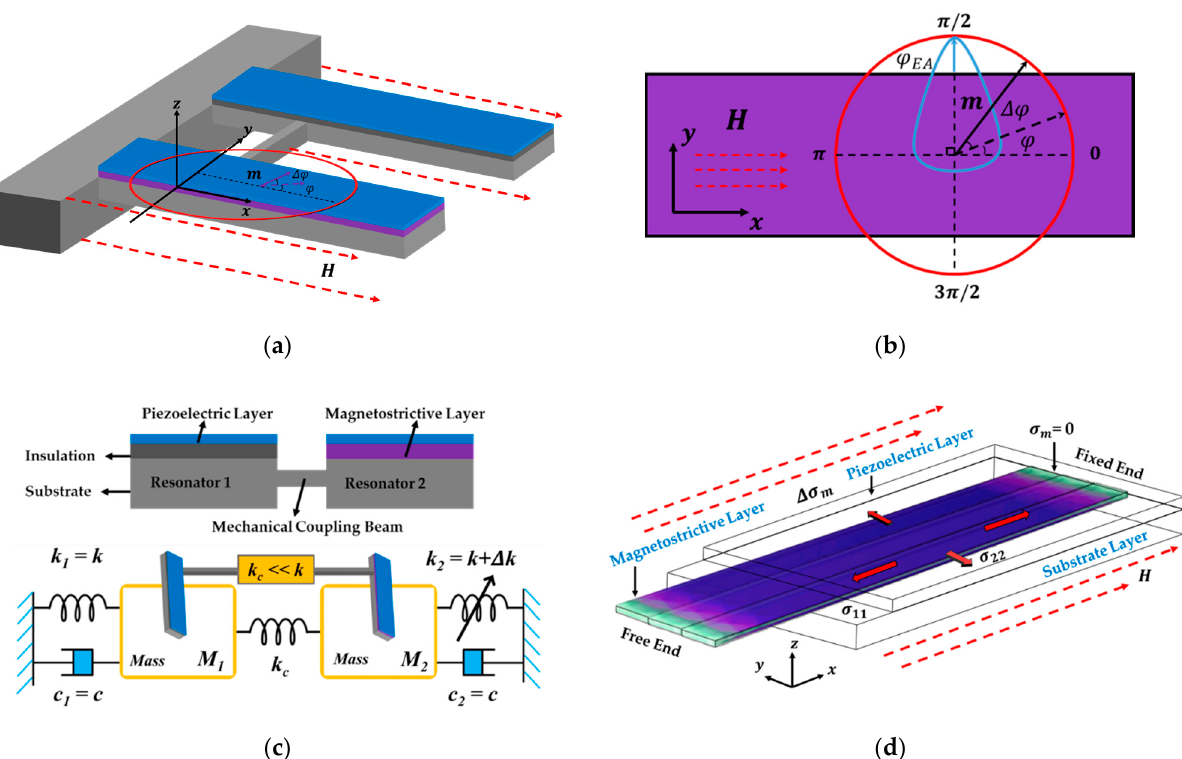
Figure 1. In-plane hard-axis magnetization process of magnetostrictive materials based on the ∆ E- effect and the structure of the weakly coupled resonator in our model. ( a ) The 3D structural diagram of the WCR with the change of magnetization and coordinate system used for the sensor analytical model; ( b ) the enlarged top view of the magnetostrictive layer in ( a ). The red circle represents the normalized in-plane magnetization process of the magnetic layer, and the blue area indicates the angular standard deviation of the easy axis; ( c ) top: the cross-sectional view of the WCR, Resonator 2 is sensitive to the magnetic field with a magnetostrictive film, while Resonator 1 is replaced with an insulating layer in the same position. The two resonators are coupled by a mechanical beam; bottom: the equivalent mass-stiffness-damping structure diagram of the WCR, which satisfies the weak coupling condition, where the stiffness of Resonator 2 is regulated by the applied magnetic field; ( d ) the stress distribution of magnetostrictive films under the ∆ E-effect is induced after applying an external magnetic field to adjust the resonator